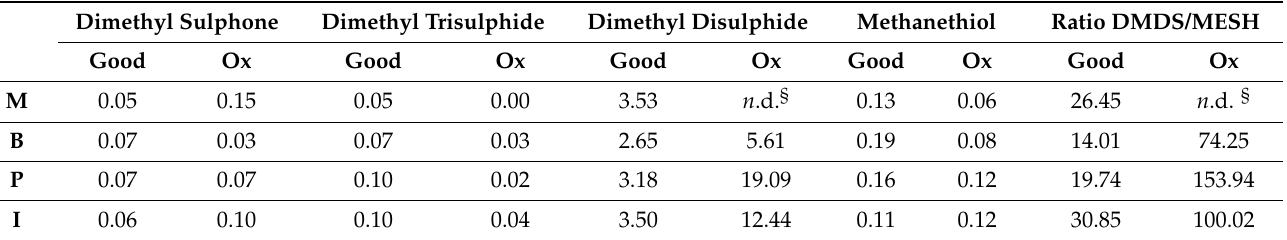
Table 3. Comparison of some sulphur markers from the literature and the DMDS/MeSH ratio in good and oxidised samples. § Under limit of